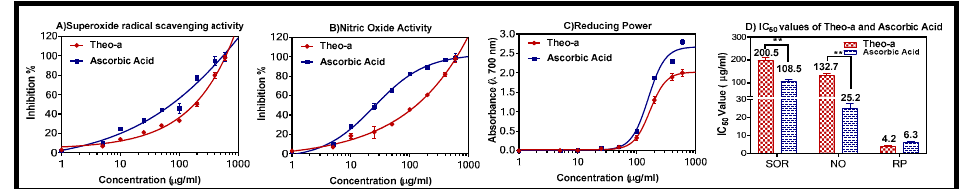
Figure 4. Dose-response inhibition of ( A ) superoxide radical activity, ( B ) nitric oxide activity, and of ( C ) reducing power of pheo-a and ascorbic acid. The half maximal inhibitory concentrations (IC 50 ) for pheo-a and ascorbic acid ( D ). All the values are expressed as mean ± standard deviation; n = 3, and ** p < 0.01.